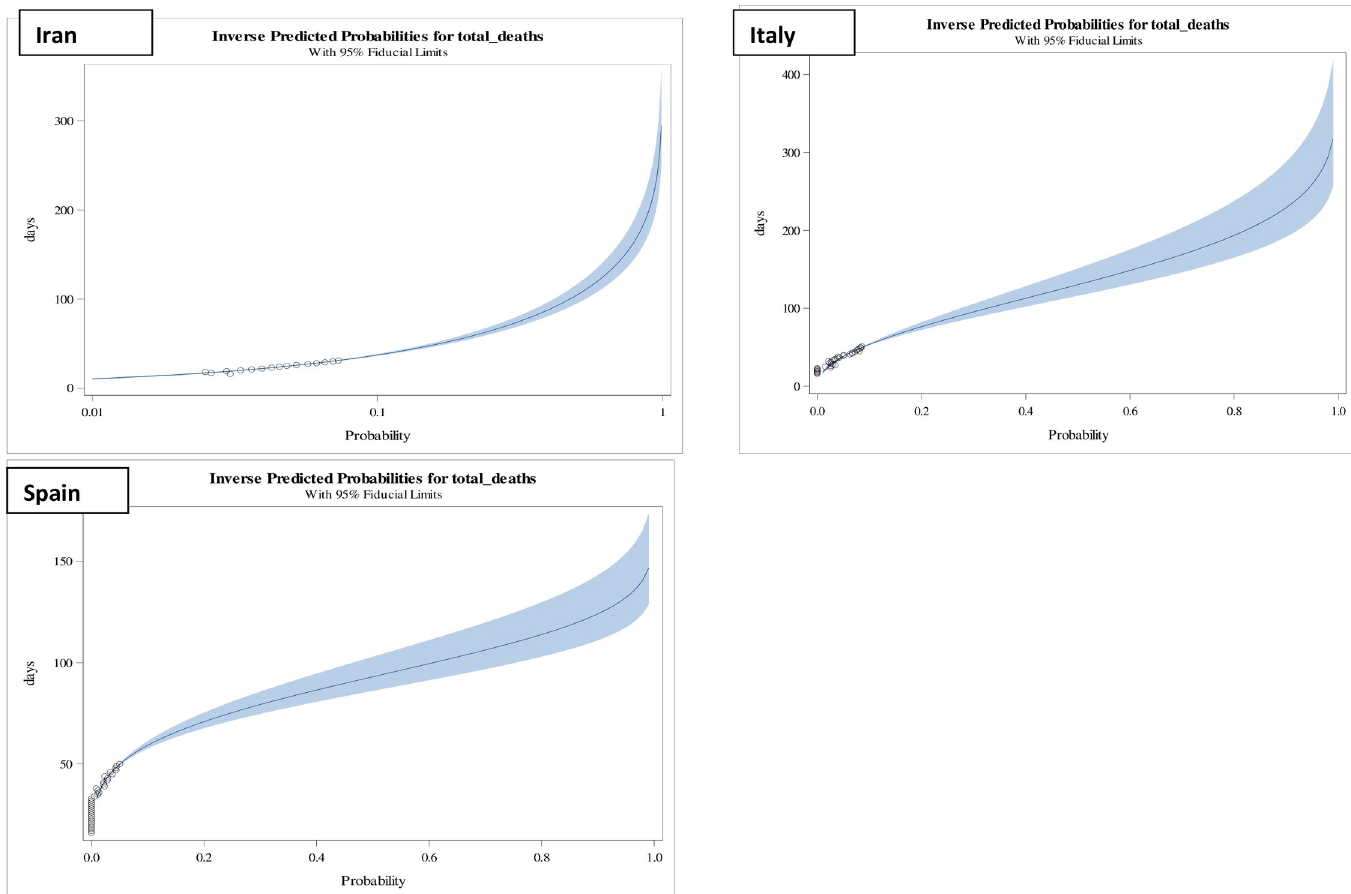
Fig 4. Inverse predicted probabilities of total deaths in counties, Iran, Italy and Spain of Category III having Class 3 (0.2–0.5) mortality rates.